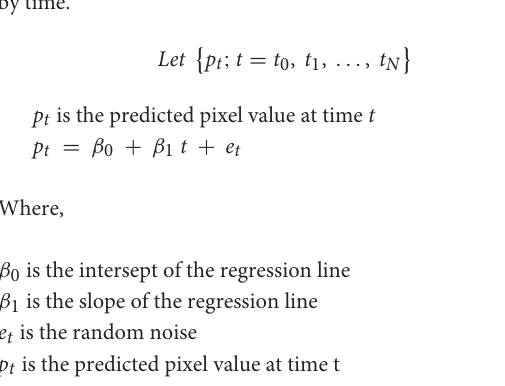
pixel values as random variables chronologically indexed by